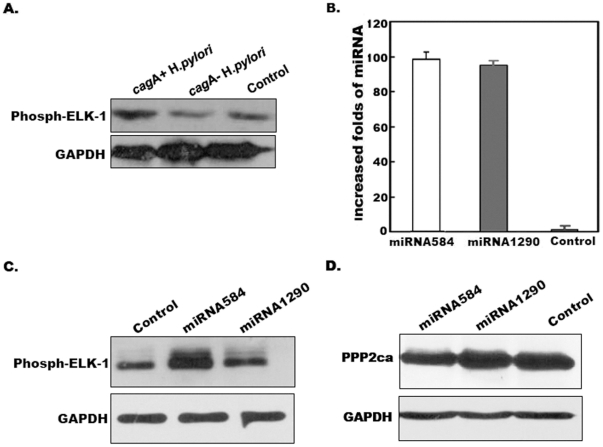

cagA+ H.pylori activated Erk1/2 kinases and miRNA-584 sustained Erk1/2 activities through inhibition of PPP2a. A. Erk1/2 kinases were activated by CagA.AGS cells were infected with H.pylori including NCTC11637 and 9 cagA– and 7 cagA+ isolates for 7 h (MOI≈50) respectively. Cells were collected and lysed at 24 h after transfection. The lysates were co-precipitated with agarose-conjugated anti-Erk1/2 antibodies, and after washing 5 times, the beads were mixed with recombinant Elk-1 and ATP. Mixtures were subjected to SDS-PAGE after denaturing and subsequently western blot analysis probed with antibodies against phosph-Elk-1. Uninfected AGS cells were also established as a control. B. Determination of miRNA-584 and miRNA-1290 in transiently transfected cells. Total RNA was extracted from gastric carcinoma AGS cells transiently transfected with plasmids containing miRNA-584 or miRNA-1290 at 24 h after transfection. Real-time PCR was performed for determination of miRNA-584 and miRNA-1290. C. Detection of Erk1/2 activities. Gastric carcinoma AGS cells were transiently transfected with plasmids containing miRNA-584 or miRNA-1290. Cells were collected and the lysates were co-precipitated with agarose-conjugated anti-Erk1/2 antibodies, and after washing 5 times, the beads were mixed with recombinant Elk-1 and ATP at 30°C for 30 min. Mixtures were subjected to SDS-PAGE after denaturing and subsequently western blot analysis probed with antibodies against phosph-Elk-1. The empty vector was also established as a control. D. Detection of PPP2ca expression. Gastric carcinoma SGC7901 cells were transiently transfected with plasmids containing miRNA-584 or miRNA-1290. Cells were collected and lysed at 24 h after transfection. Lysates were subjected to SDS-PAGE after denaturing and subsequently western blot analysis probed with antibodies against PPP2ca. Data are represented as mean +/− s.e.m.